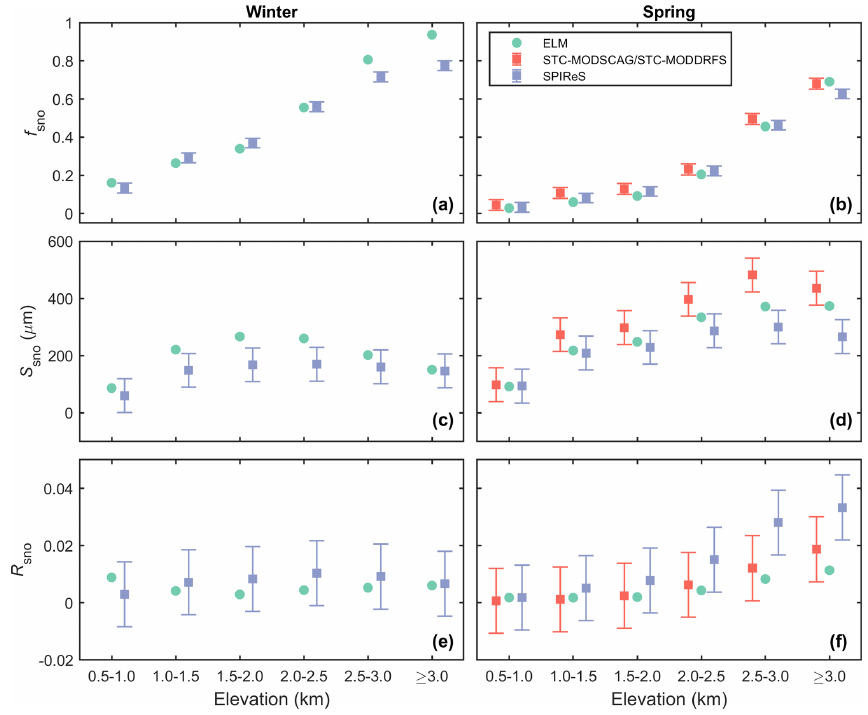
Figure 5. The area-weighted average (a, b) snow cover fraction ( f sno ), (c, d) snow grain size ( S sno ), and (e, f) snow albedo reduction ( R sno ) for (a, c, e) winter and (b, d, f) spring of ELM (green), STC-MODSCAG/STC-MODDRFS (red), and SPIReS (blue) over the WUS. The bar width represents the uncertainty bounds of STC-MODSCAG/STC-MODDRFS and SPIReS from Bair et al. (2021a).